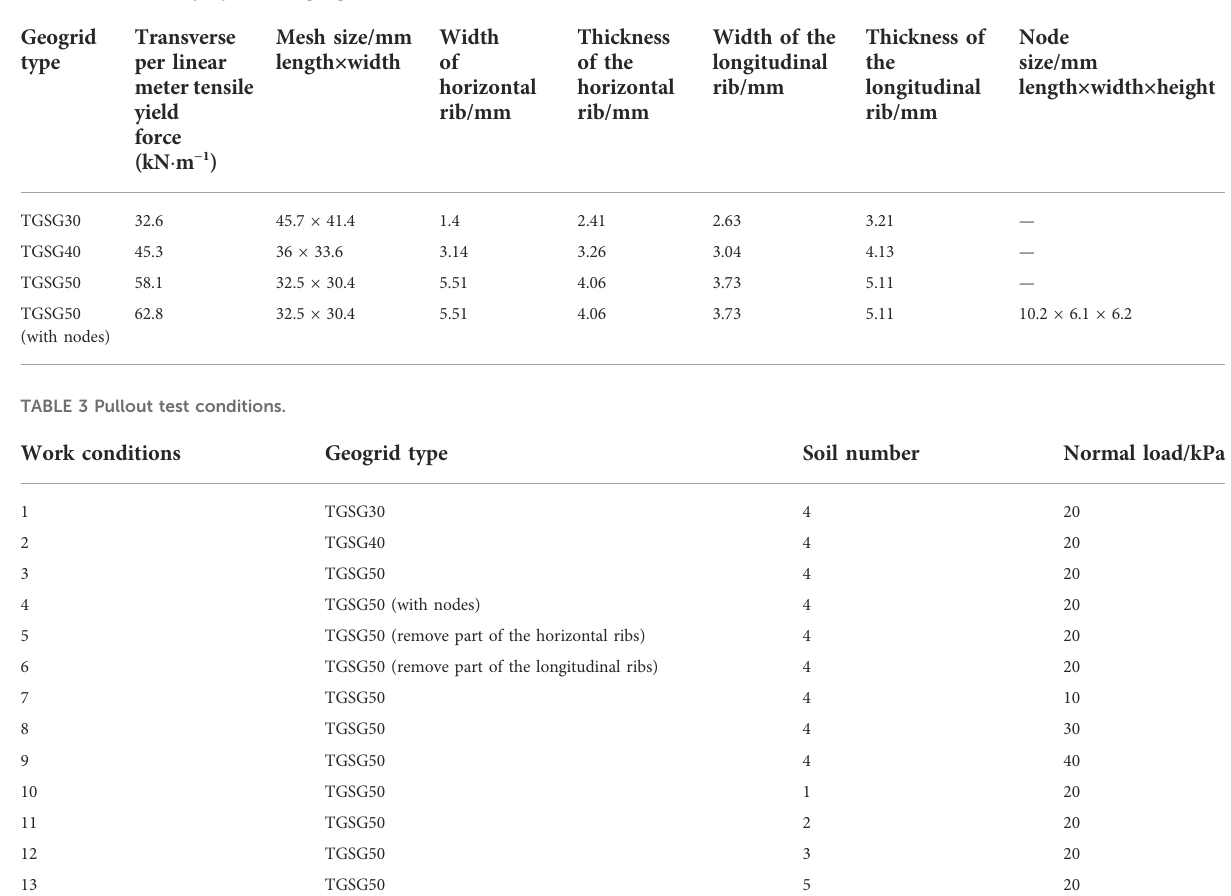
TABLE 2 Mechanical properties of